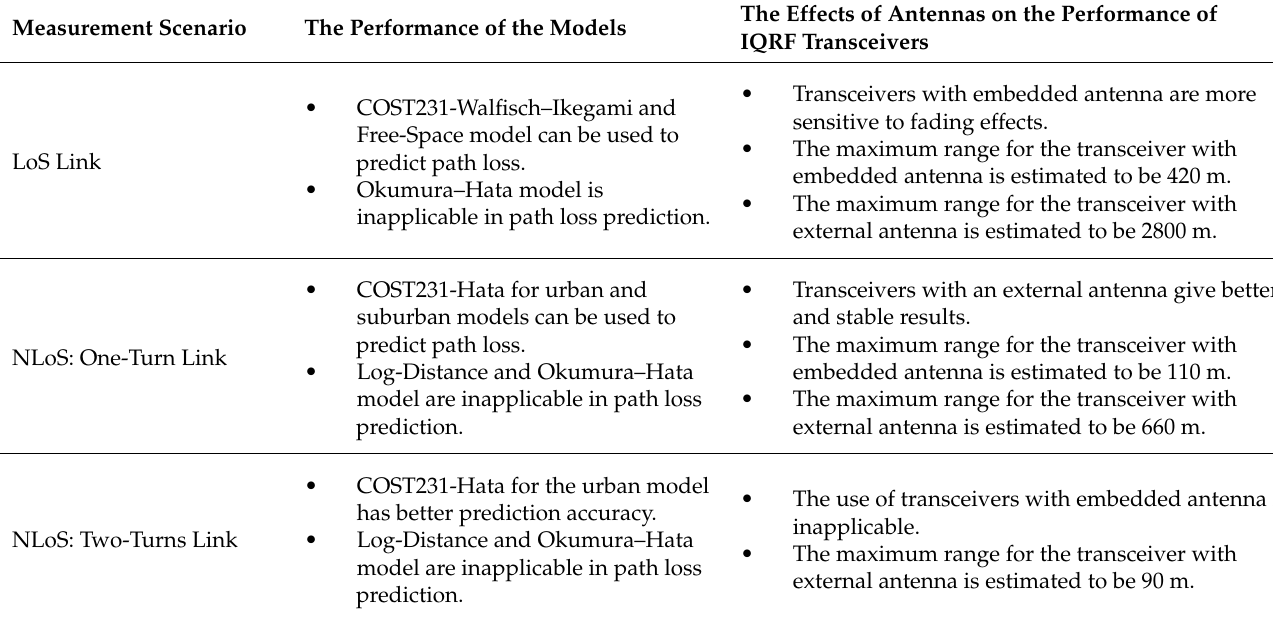
Table 13. Summary of the achieved results. The Effects of Antennas on the Performance Measurement Scenario The Performance of the Models